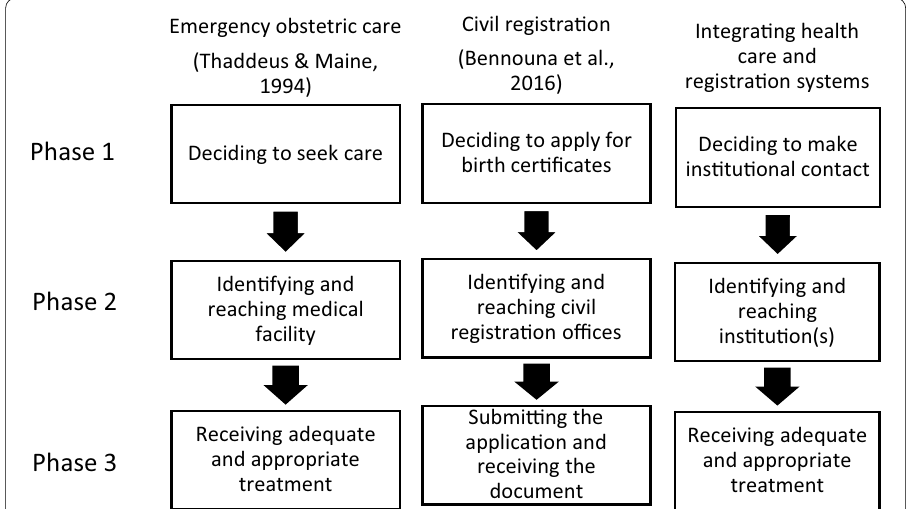
Fig. 1 Comparing adaptations of the three delays